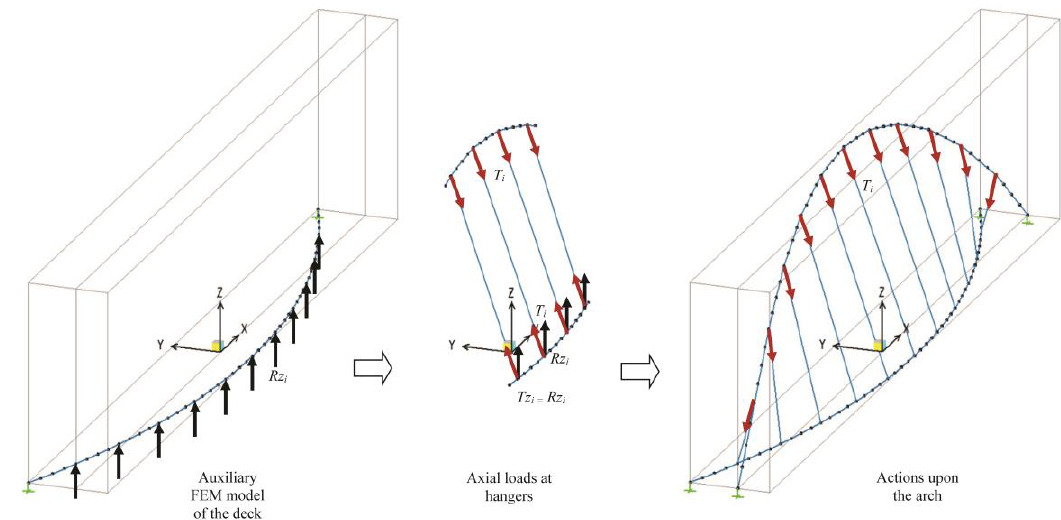
Figure 9. Actions upon the arch transferred by hangers.